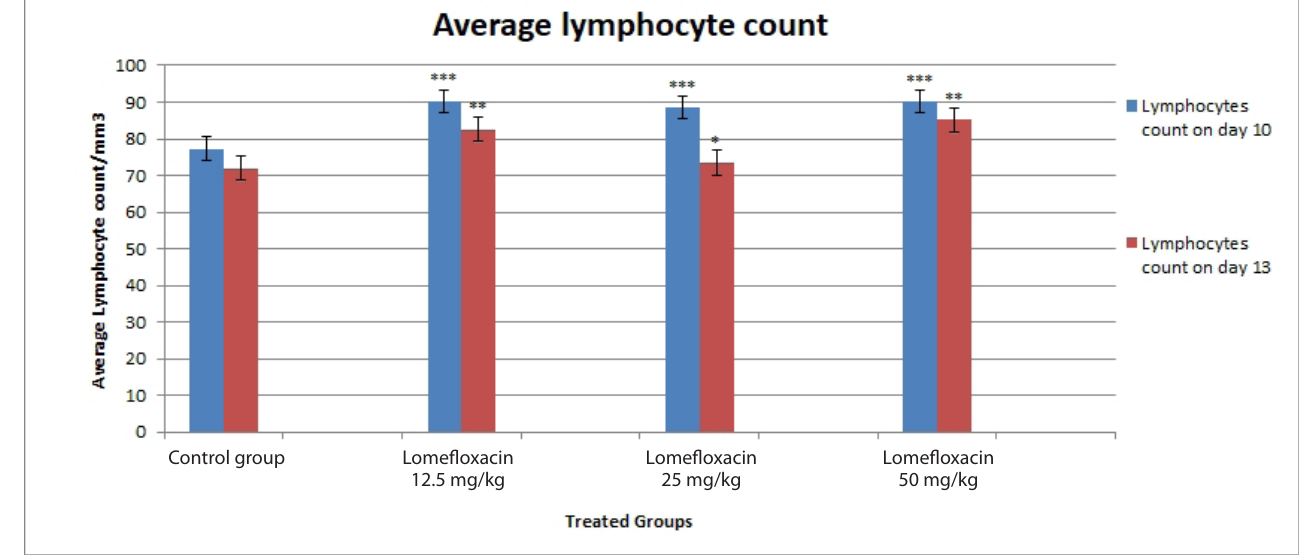
FIGURE 2 (B ) - Lymphocytes count before and after cyclophophamide